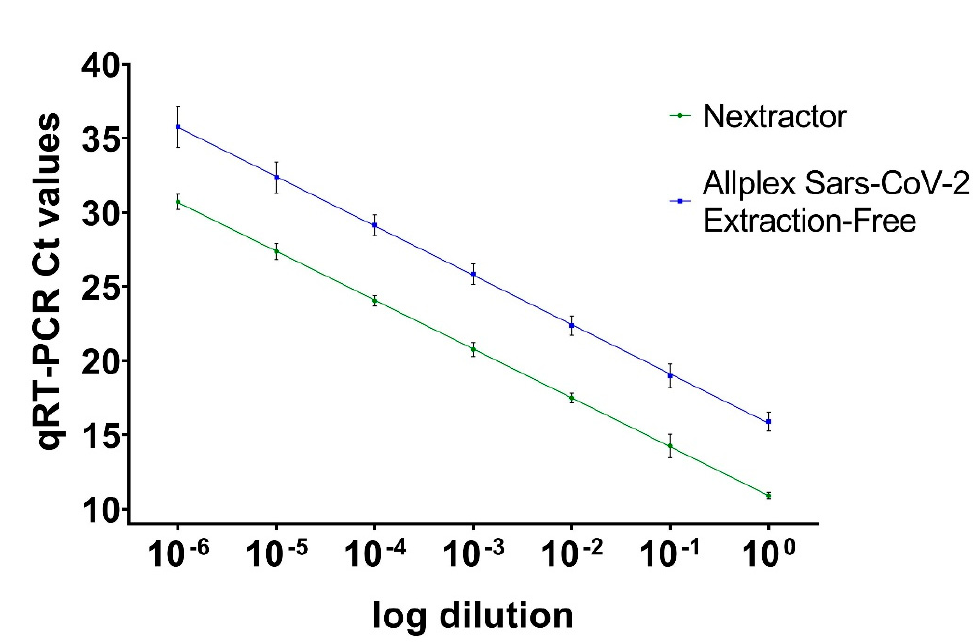
Figure 1. Ct values obtained with preliminary RNA extraction (Nextractor shown in green line) and the extraction-free protocol (Allplex severe acute respiratory syndrome coronavirus 2 (SARS-CoV-2) Extraction-Free, shown in blue line). Ct values are presented as the mean of six replicates for each dilution ± standard error (SE).